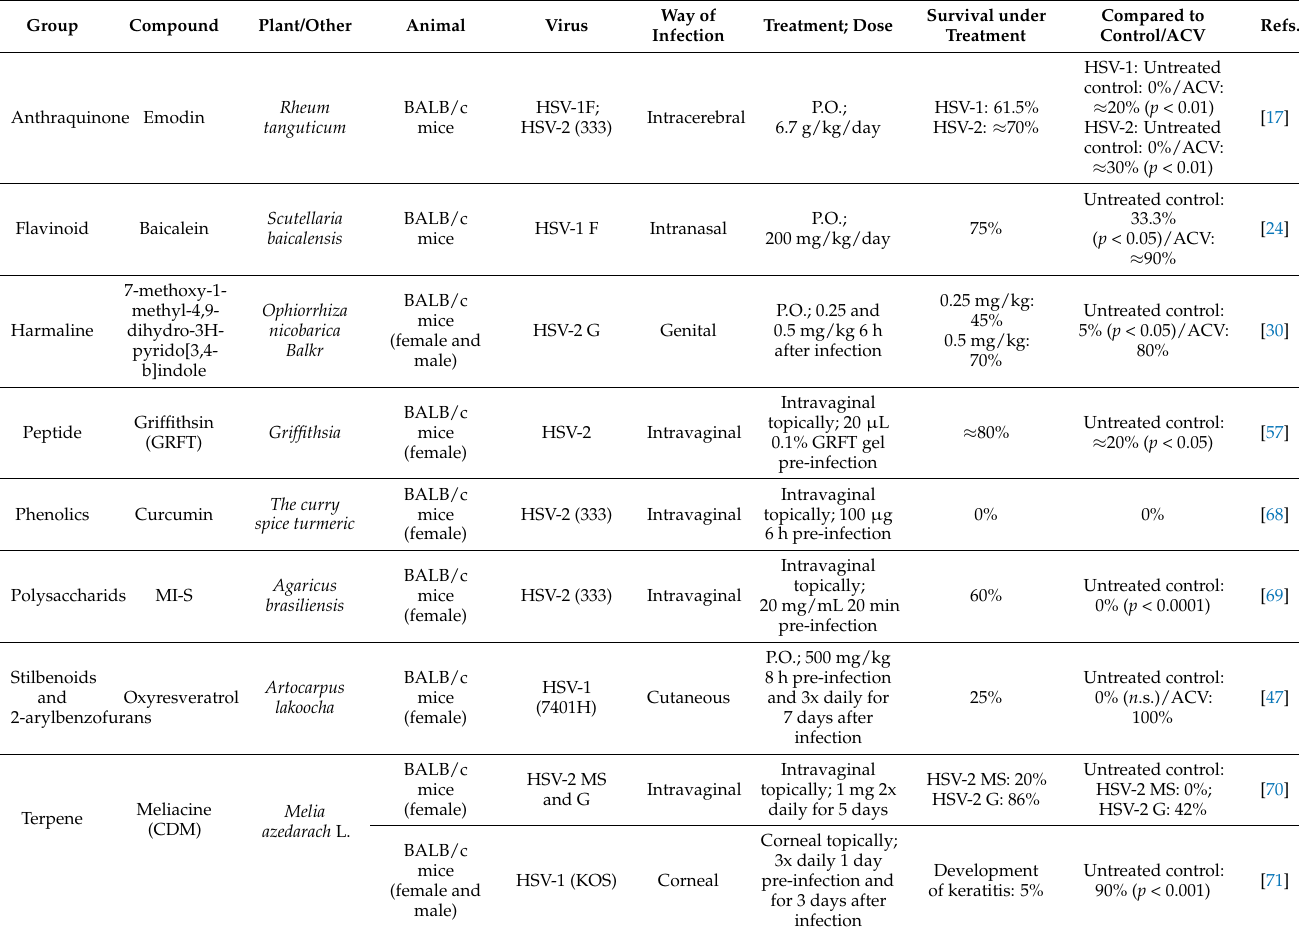
Table 2. In vivo studies of anti-HSV chemical substances. P.O. = Per